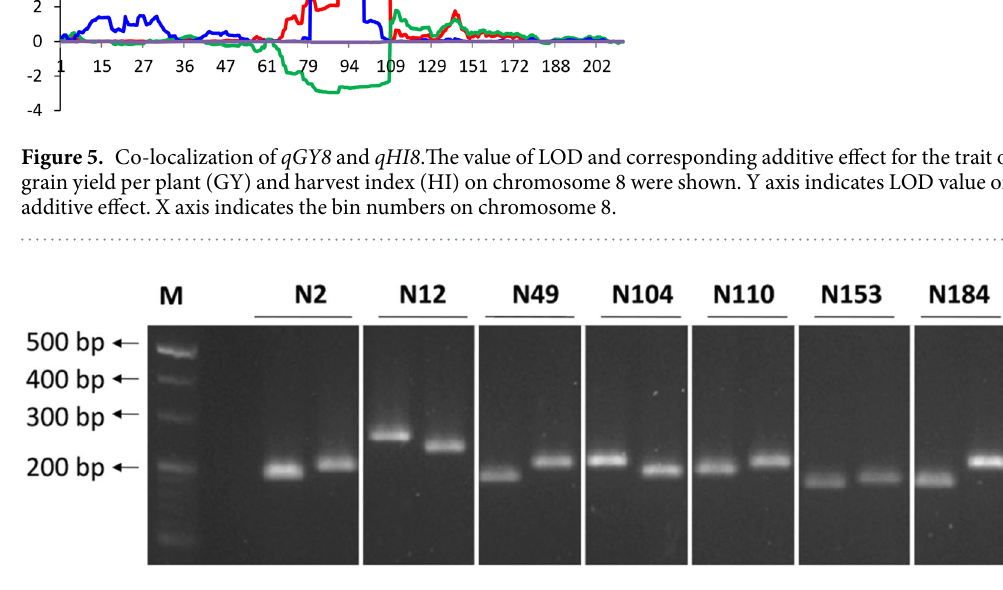
Figure 6. Development of tightly linked InDel markers in the qGY8 region. M, 20 bp DNA ladder (TaKaRa). For each pair of samples, the left well represents R998 and the right well stands for Francis, respectively. PCR products were separated on 3% agarose gel. The full-length gel is presented in Supplementary Figure